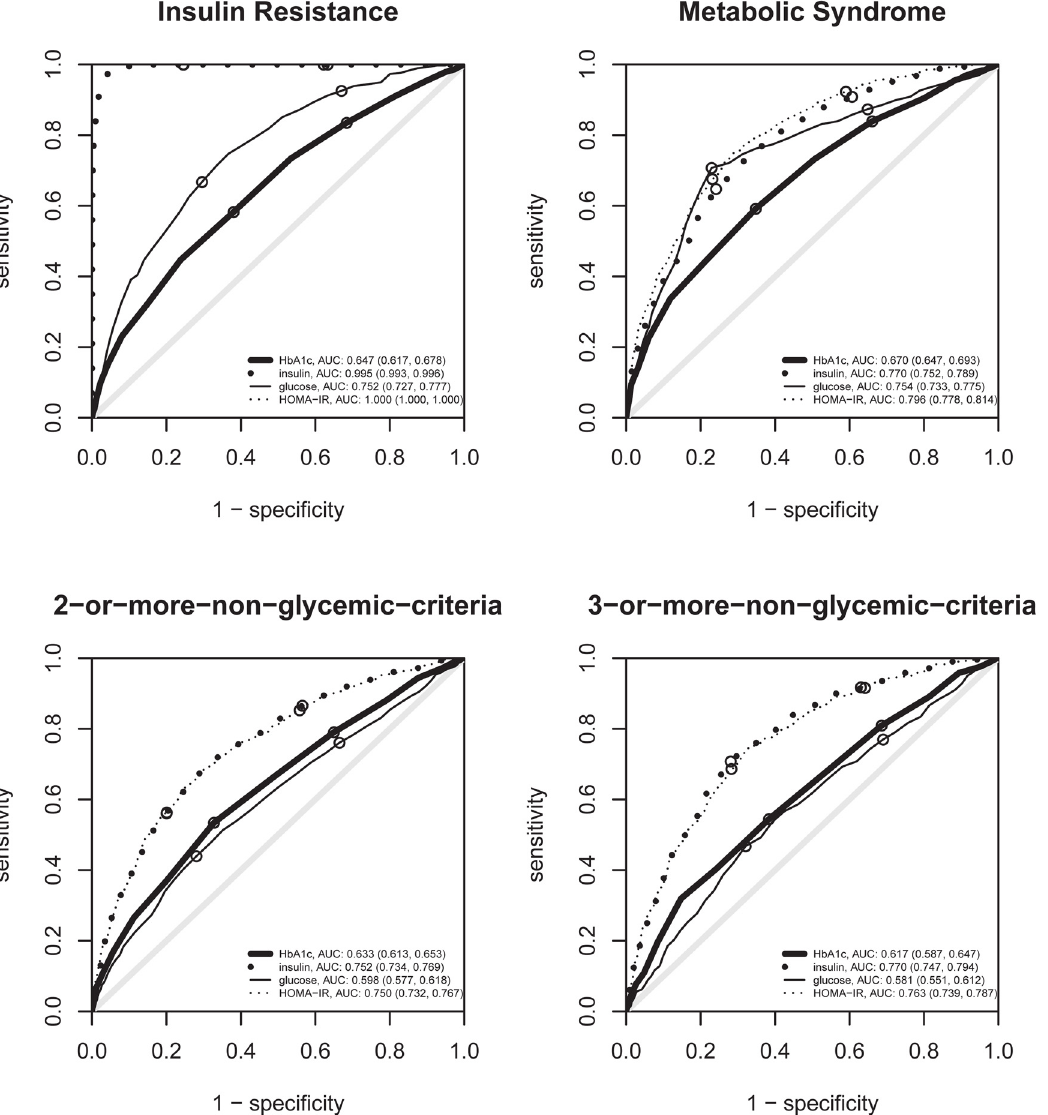
Fig 2. ROC curves of HbA1c, insulin, glycemia and HOMA-IR for insulin resistance and criteria clusters. ROC curves for detecting insulin resistance, the metabolic syndrome, 2 or more, and 3 or more criteria for the metabolic syndrome other than the high glucose criterion. The small circles indicate the sensitivity and specificity when using the tertiles of each variable as cut-offs. For insulin resistance, the HOMA-IR curve can not be seen as it lies exactly at the left and upper borders.